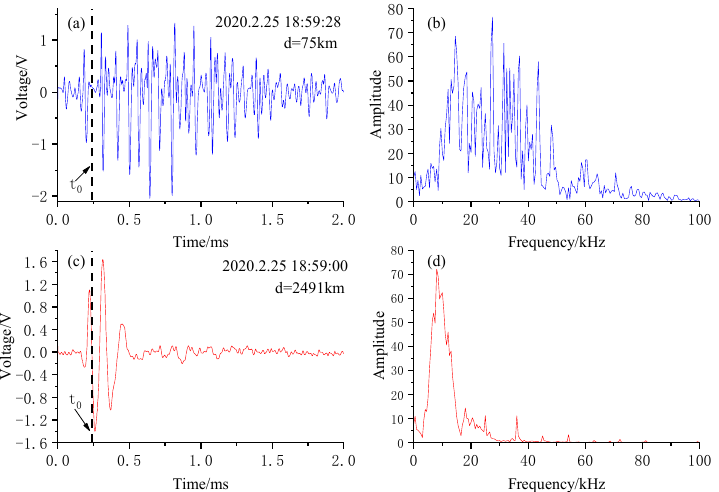
Figure 4. Time and spectrum plots of electric field signals in the near (75 km) and far (2491 km) regions. The blue lines represent near-field lightning signals, ( a ) time-domain plot, and ( b ) spectrum plot. The red lines represent far-field lightning signals, ( c ) time-domain plots, and ( d ) spectrum plots. The marked time is the time t 0 when the signal triggers sampling, and d is the distance from the lightning signal to the detection site.